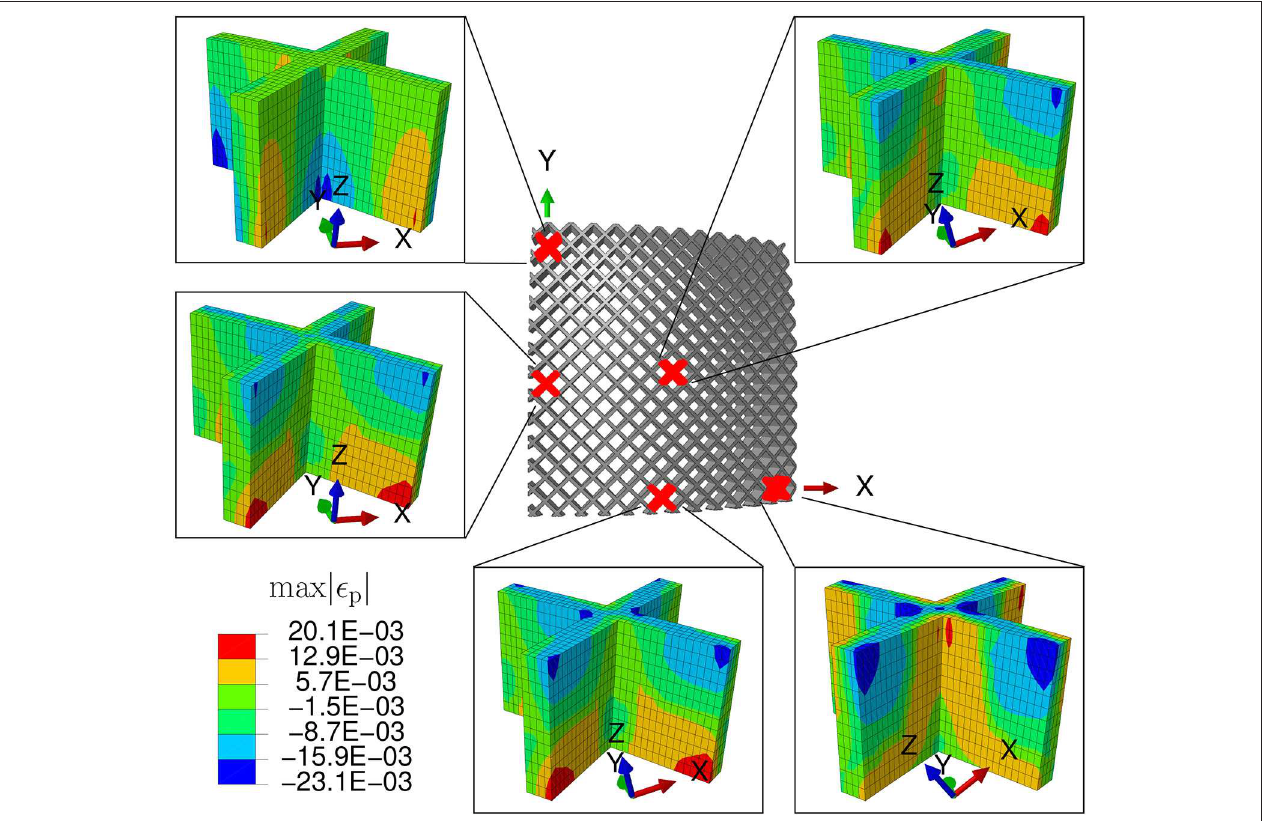
FIGURE 7 | The local deformation of the structure at five locations on a quarter of the shell at the end of the simulation, i.e., while in the second stable geometry. The contours show the maximum (absolute value) principle strain.